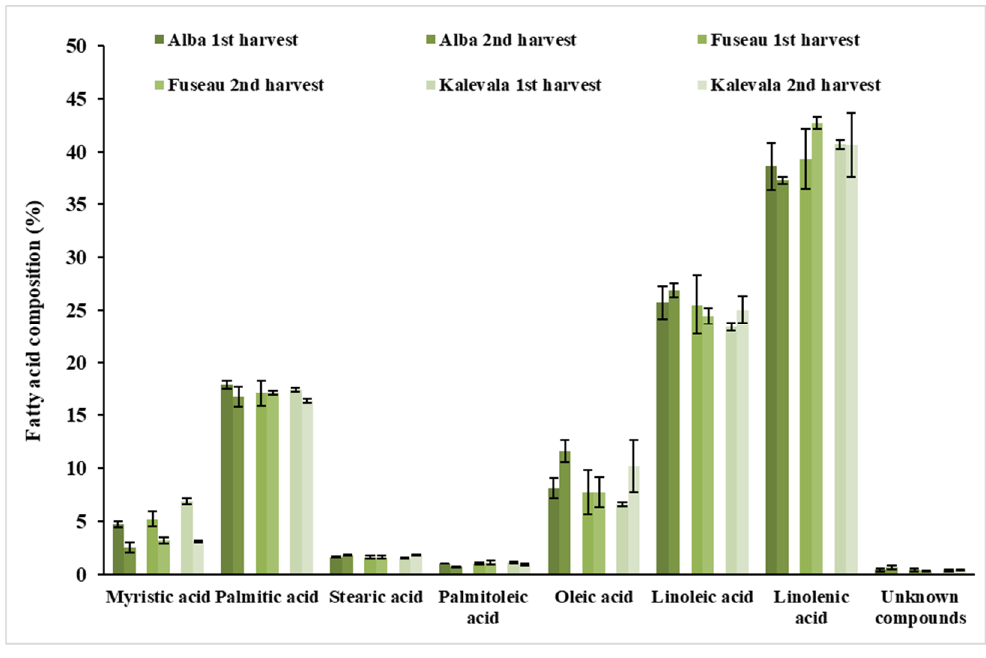
Figure 1. Fatty acid composition (%) of Jerusalem artichoke leaf protein concentrate (JAPC) extracted from the green biomass of three clones (Alba, Fuseau, and Kalevala).